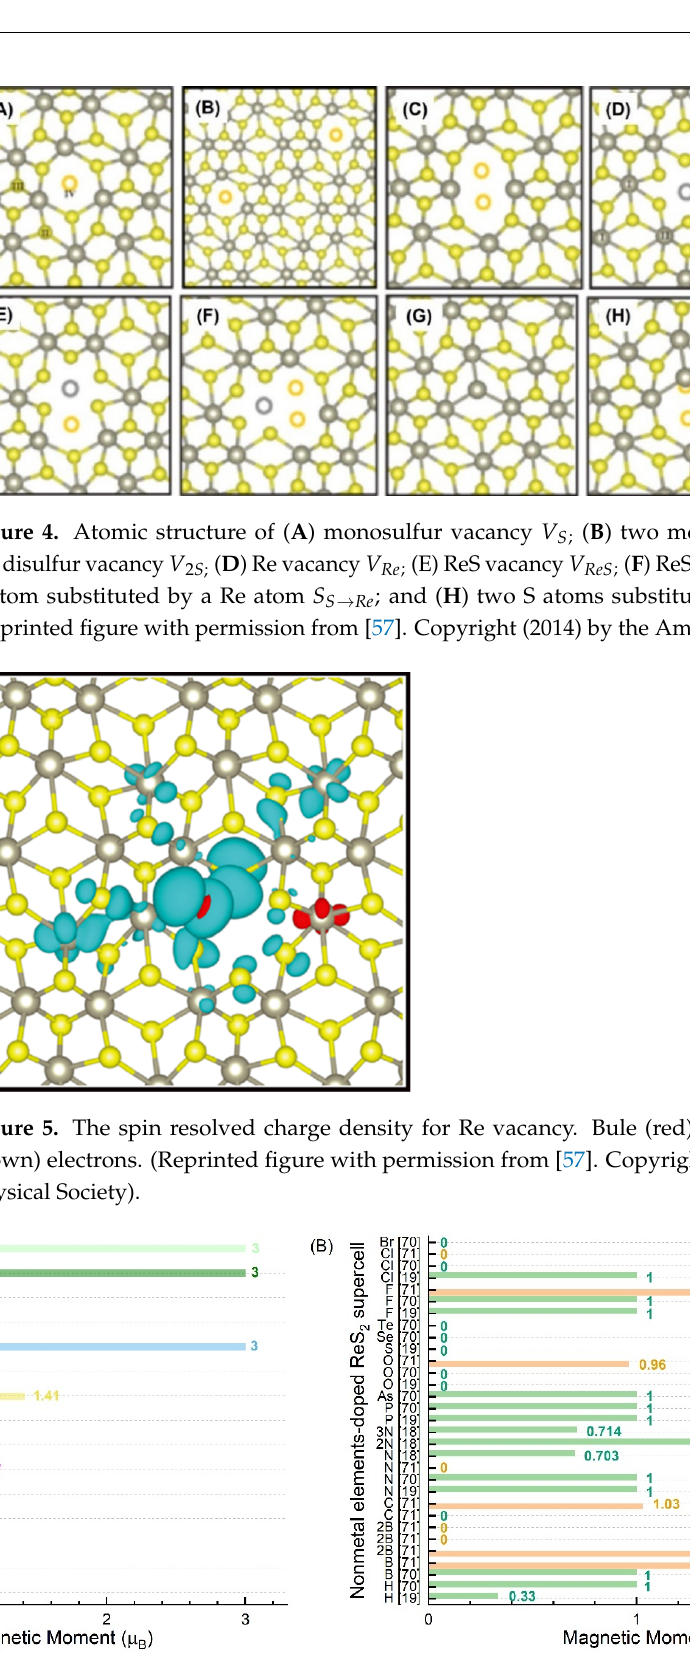
Figure 6. Calculated total magnetic moment in ReS 2 supercell with different point defects ( A ) and different nonmetallic elements doped ( B ) [17–19,27,57,64,70,71]; T d phase: noncentrosymmetric; T c phase [17]: centrosymmetric metallic.